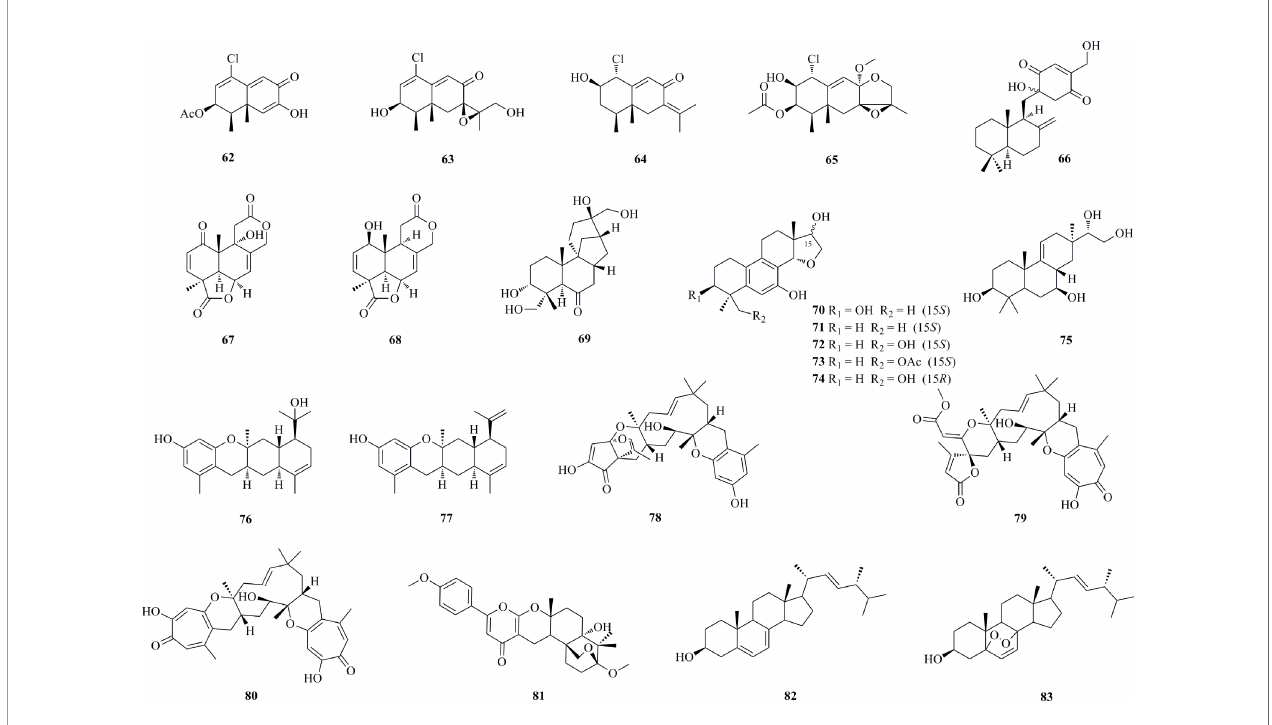
FIGURE 5 | Terpenoids and steroids isolated from deep-sea fungi ( 62 − 83